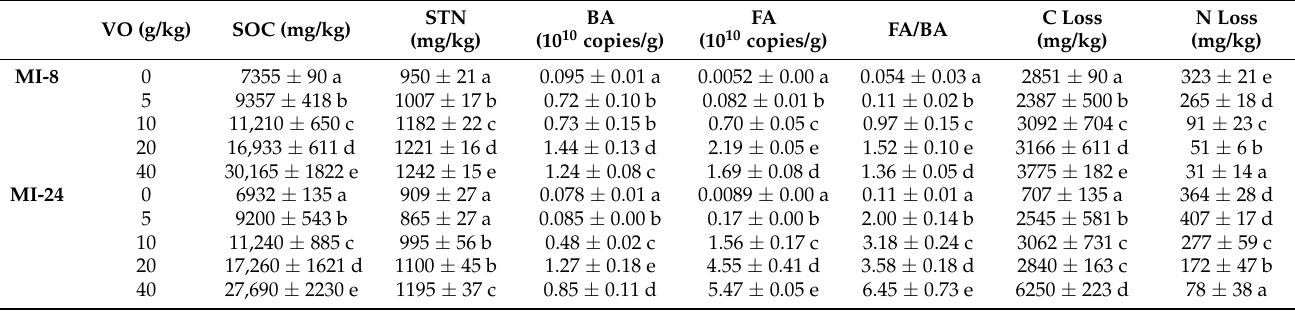
Table 1. Soil health indicators of the simultaneous application of fertilizer and vegetable oil (SIFVO) treatments under different VO application rates in the mesocosm incubation (MI) experiment and the pot culture (PC)